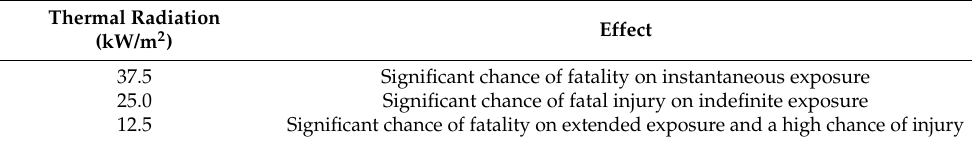
Table 5. Effect of thermal radiation.